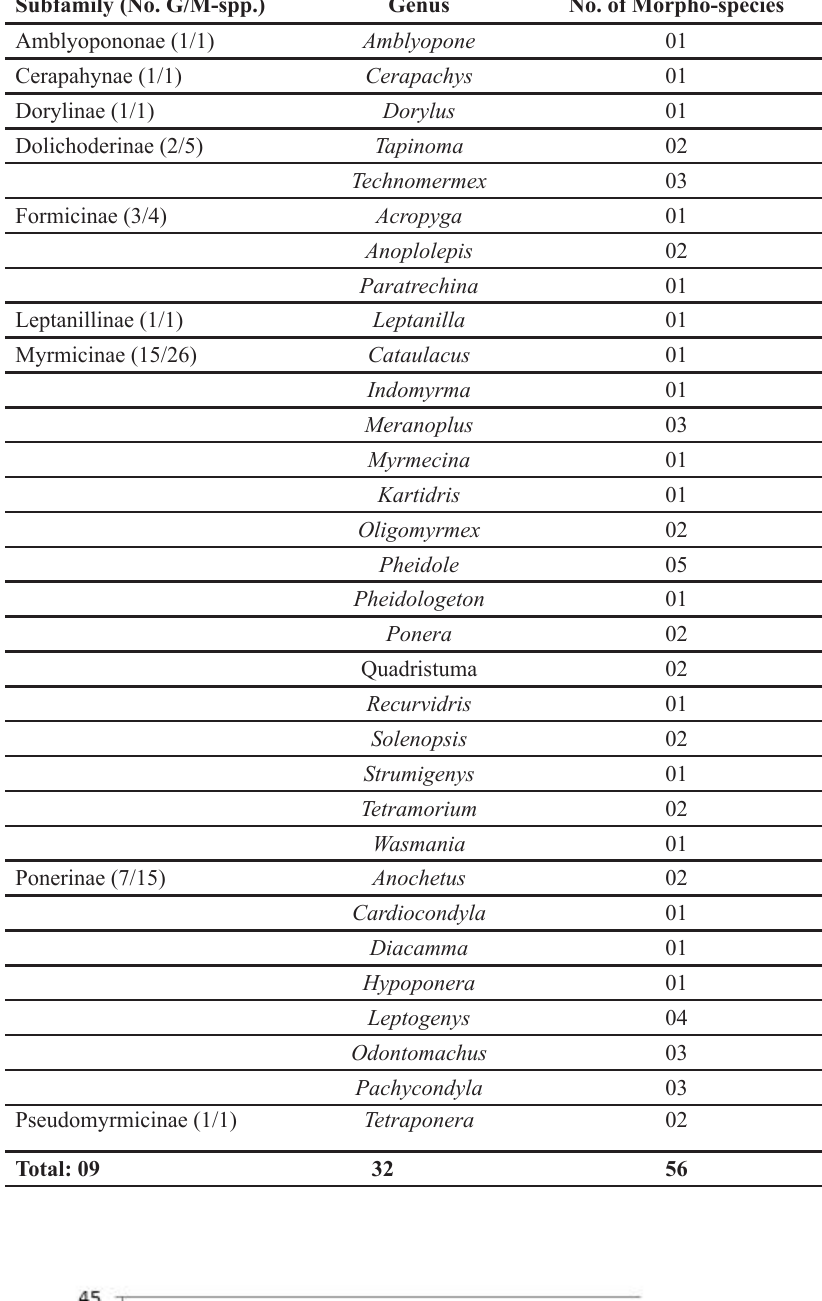
Table 1: Subfamily, Genera and the number of morpho-species of ants collected from the Hanthana Forest Reserve.